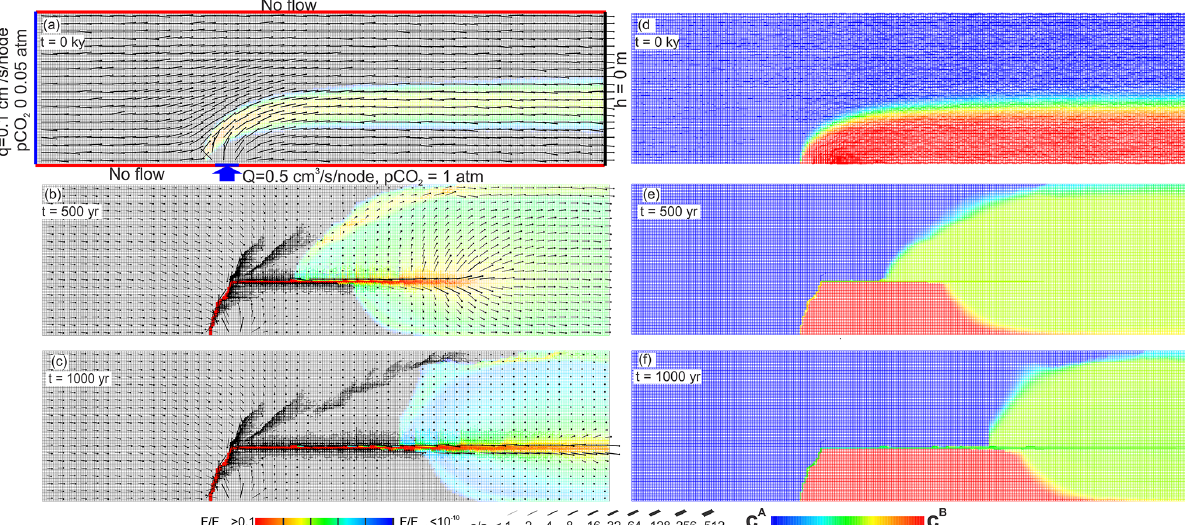
Figure 20. Evolution of the confined aquifer. The left panels represent fracture aperture widths (bar code below) and widening of the fractures in cmyr − 1 (colour code below). Black regions do not experience widening by dissolution. The right panels represent flow rates (bar code Q/Q max , where Q max is the maximal flow occurring in the net) and the values of c eq (colour code) of the water. Blue regions contain phreatic water from the input on the left-hand side of the modelling domain. Red regions are filled with upwelling water from